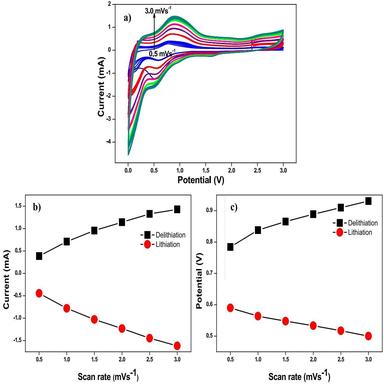
a) Cyclic voltammograms at different sweep rates(0.5 to 3 mV/s) b) variation of current vs. scan rates c) variation of voltage vs. scan rates.